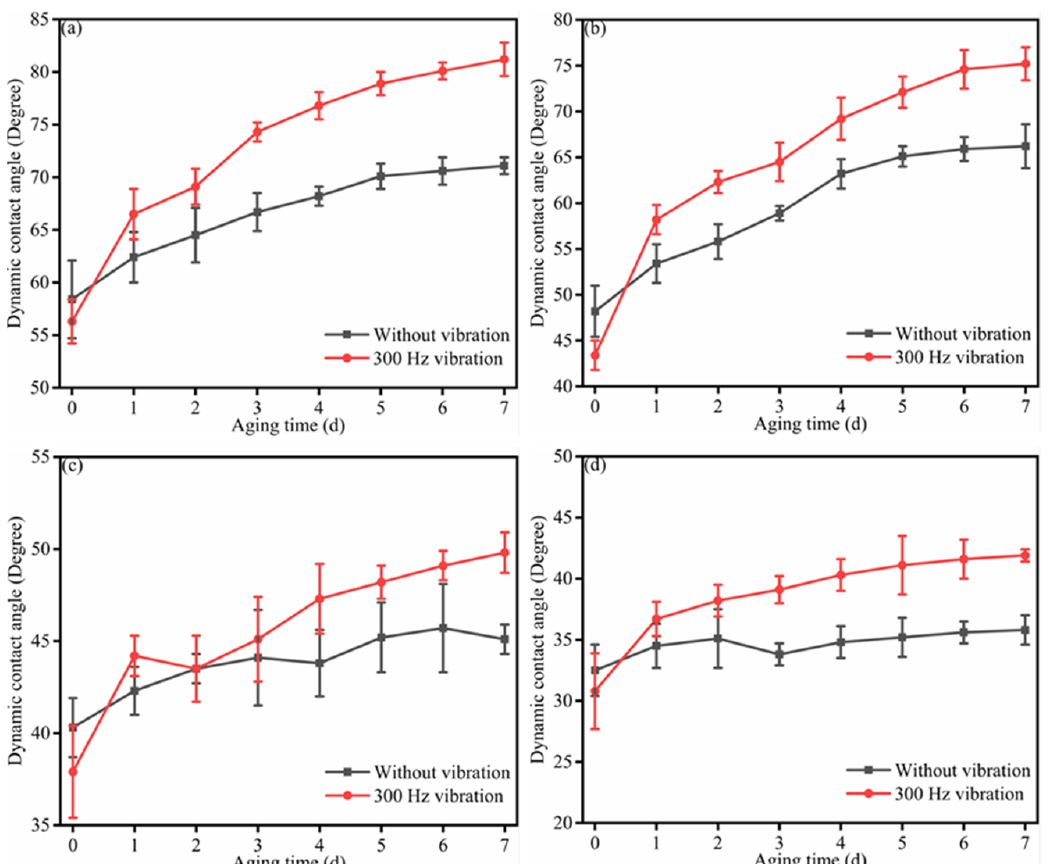
Figure 3. The static contact angles of water drops onto the ( a ) iron casting; ( b ) steel; ( c ) PVC; ( d ) PE, without or without 300 Hz vibration with different aging time.